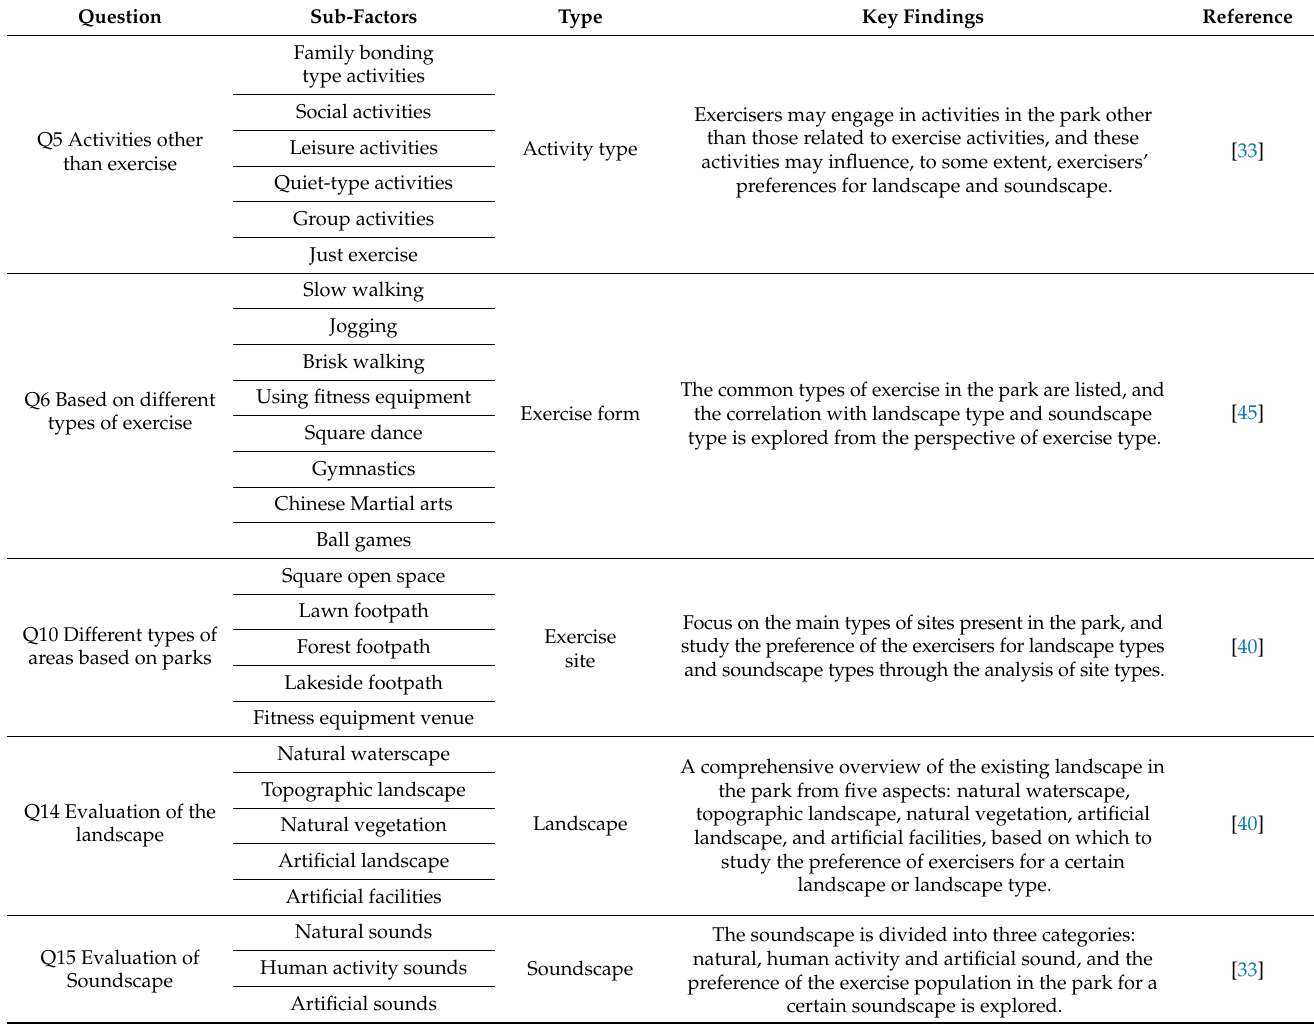
Table 1. Exerciser landscape and soundscape preference